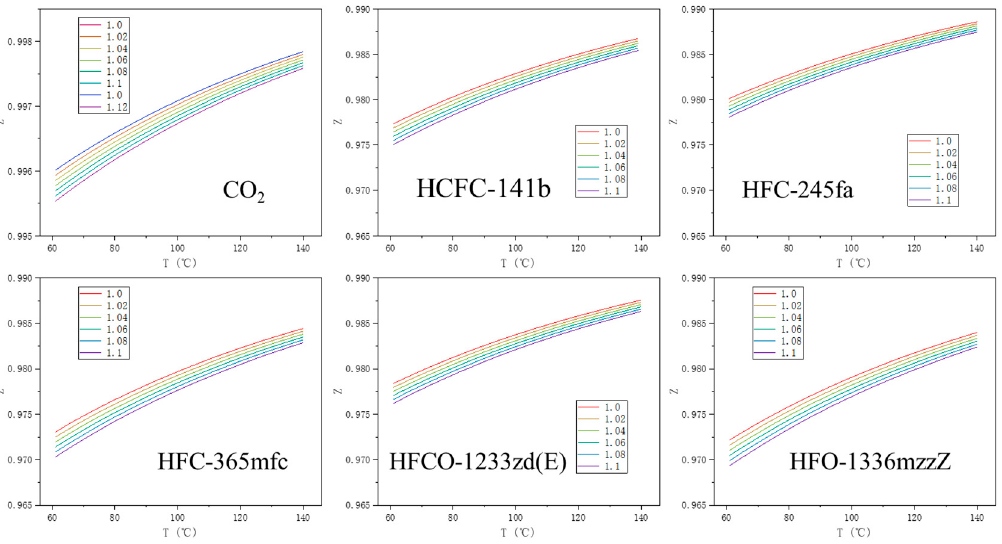
Figure 7. The compression factor of CO 2 , Z , and different PBAs as real gases at different pressures and temperatures. The different colored curves in the figure represent the value of the compression factor, Z , with the temperature at different pressures. The unit of the number in the legend data frame in the figure is 10 5 Pa.